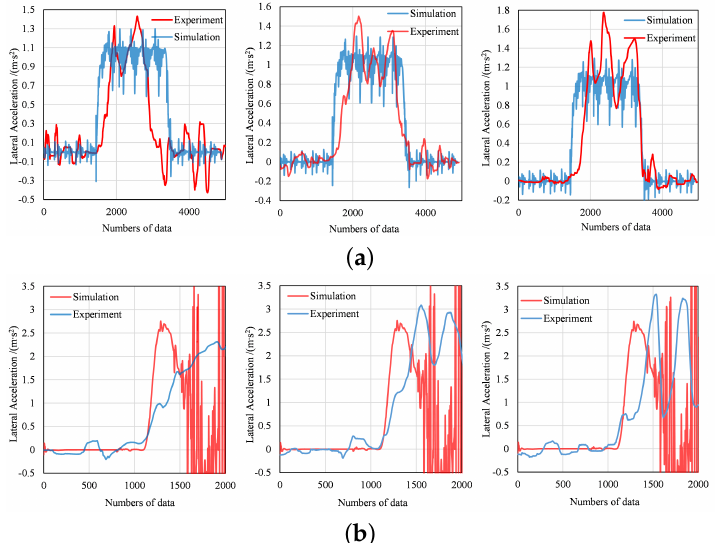
Figure 20. Lateral acceleration of experimental and simulation results under different wind speeds and driving speeds. ( a ) Crosswind speeds of 62 km/h, 68 km/h, and 74 km/h at a driving speed of 30 km/h. ( b ) Crosswind speeds of 62 km/h, 68 km/h, and 74 km/h at a driving speed of 40 km/h. As can be seen from Figure 21, under the same speed conditions, with the wind speed increased, the vehicle’s driving stability decreased continuously; similarly, under the same wind speed conditions, vehicle’s driving stability changed drastically with the speed change. When the speed exceeded the suggestion speed, the lateral displacement changed amplitude and changed frequently, the vehicle could have been involved in an accident if the driver had not constantly adjusted the